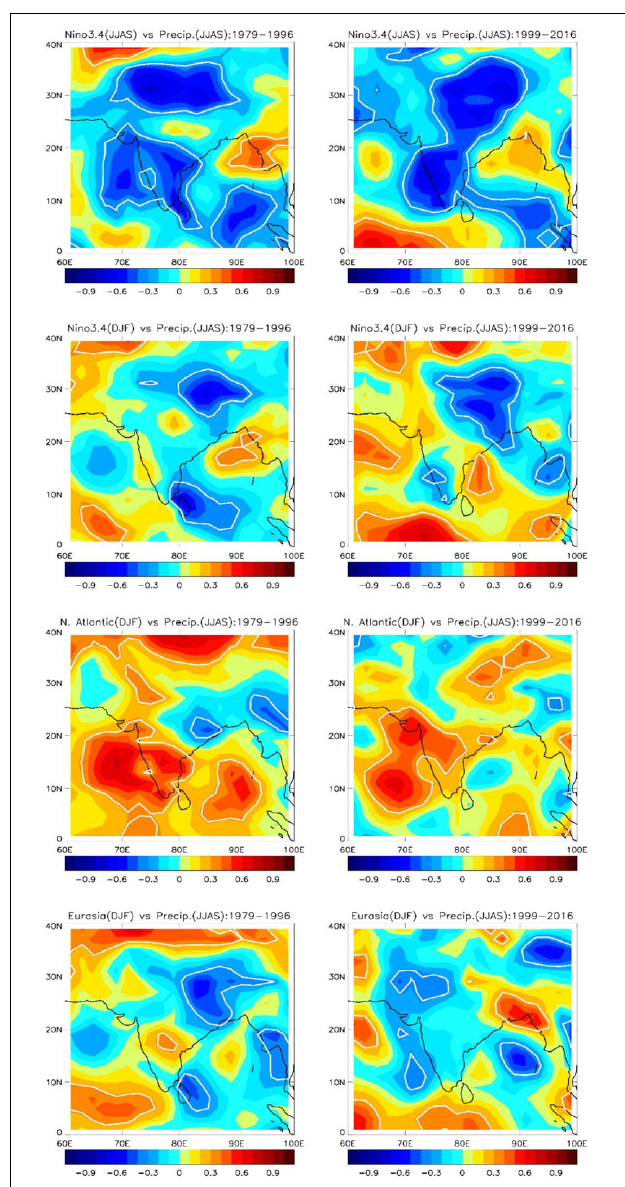
FIGURE 11 | Correlation between various temperatures related fields and Indian Summer Monsoon (ISM) rainfall (in JJAS) and some lead-lag analyses. The top two panels use Niño 3.4 temperature and the bottom two for the temperature of North Atlantic and Eurasian sector, respectively. The top panel shows correlation using Niño 3.4 temperature of JJAS, while the bottom three panels consider temperature fields of DJF. Left panel for 1979–1996 and the right for 1999–2016. Significant regions at 95% level, using a student’s t -test are marked by white lines.